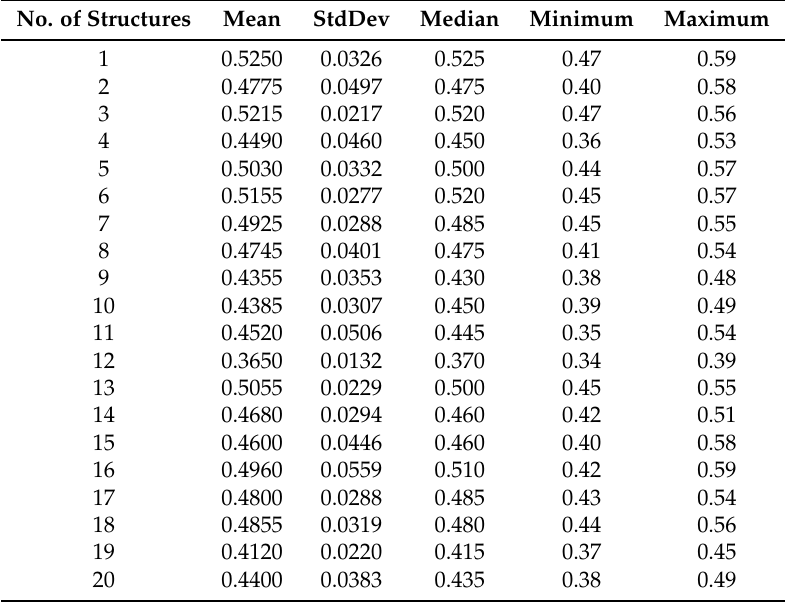
Classification error rate (in %) of the 20 best solutions (CNN architectures) of the MBO-ABCFE